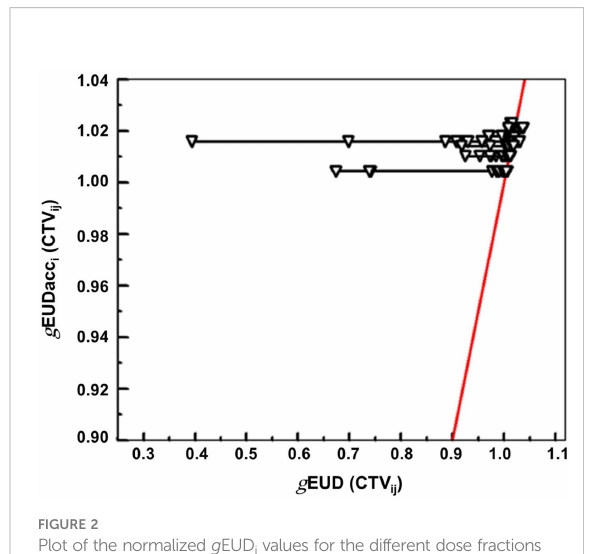
FIGURE 2 Plot of the normalized g EUD i values for the different dose fractions of a series versus the normalized g EUD for the accumulated dose distribution. The data are given for the clinical plan for the 10 patients. The red line represents the 1:1 line connecting the accumulated g EUD acc_j values for the different